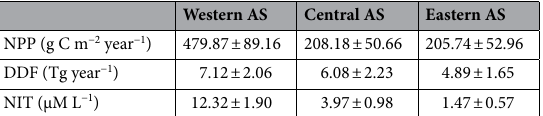
Table 1. Regional average values of NPP (2007–2018), DDF (2007–2018) and NIT (2007–2015) during